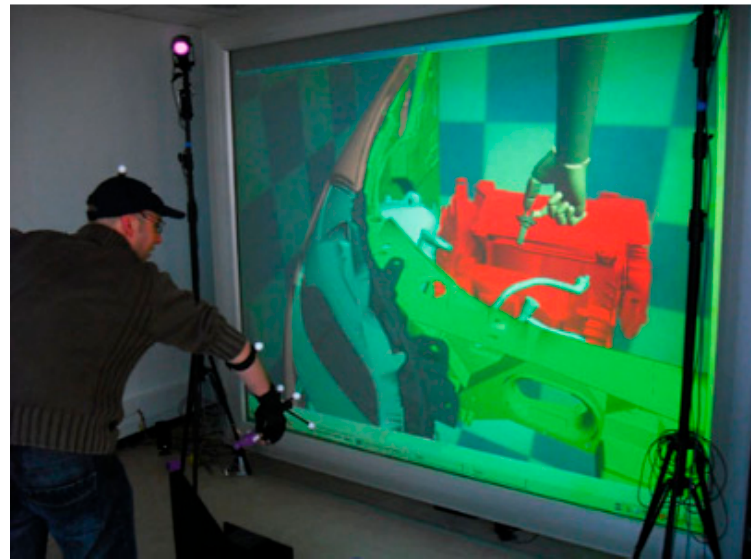
Figure 8. SPIDAR-based interaction system. Reproduced with permission from [113], Springer Nature, 2010.